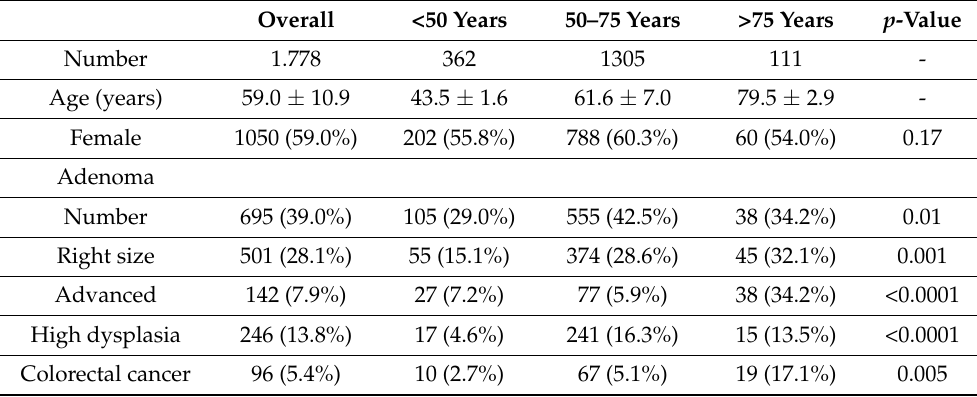
Table 3. Colonoscopy screening